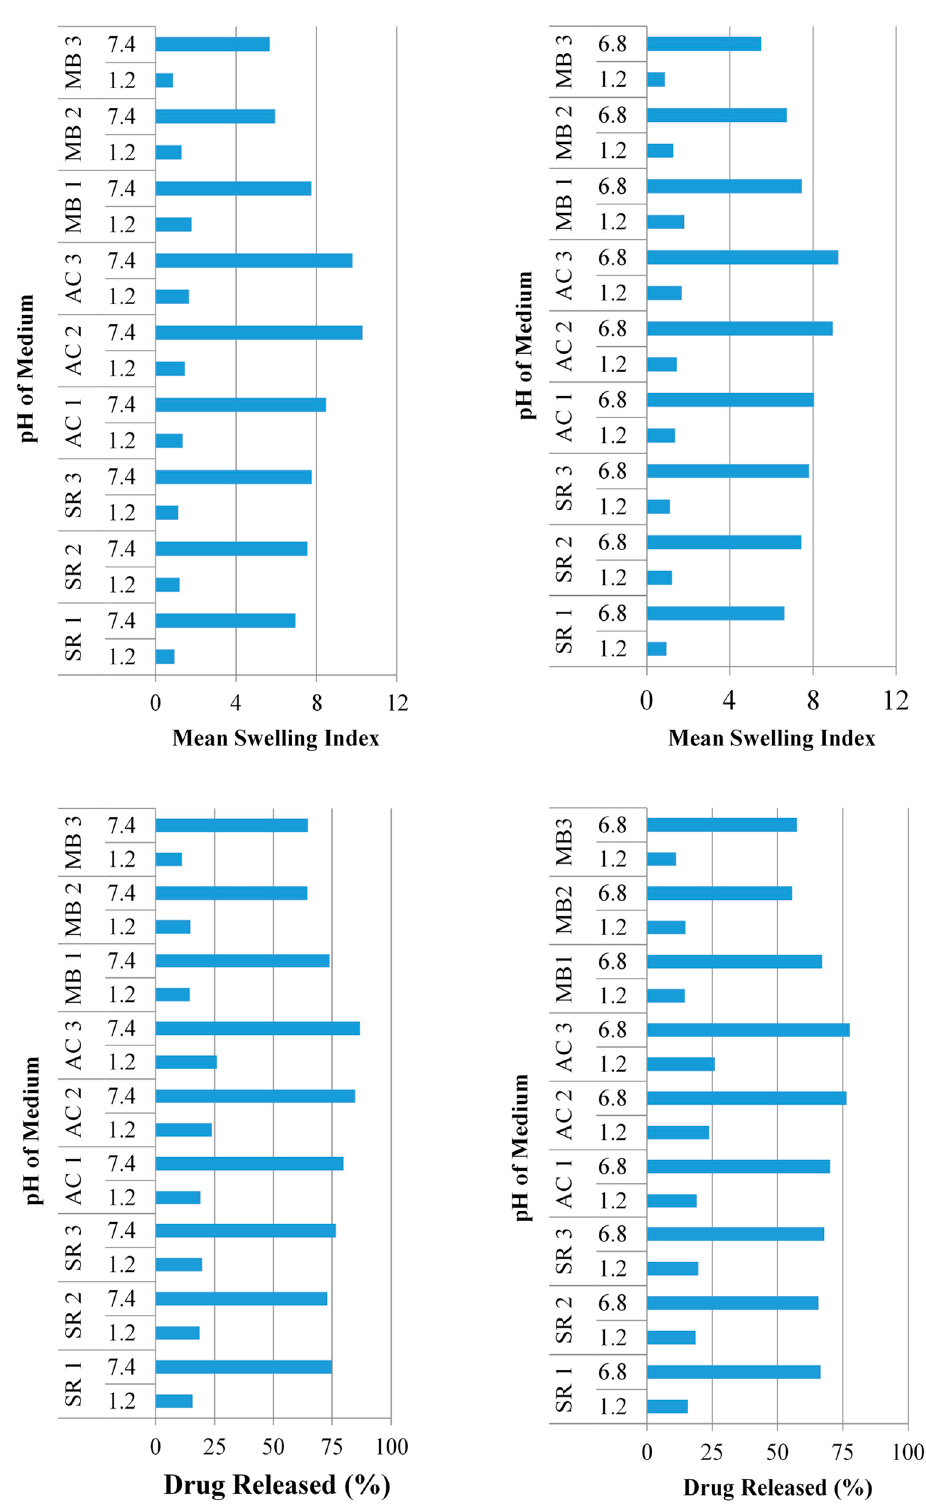
Figure 4. Comparison among in-vitro swelling dynamics and release behavior of all formulations at pH 1.2, 6.8, and 7.4. Formulations with increasing feed ratios of AA (AC1-AC3) resulted in an increased swelling (Figure 5) at pH 1.2 ( p = 0.01), 6.8 ( p = 0.009), and 7.4 ( p = 0.006). In the same way, drug release was significantly improved at pH 1.2 ( p < 0.001), 6.8 ( p = 0.001), and 7.4 ( p = 0.001).